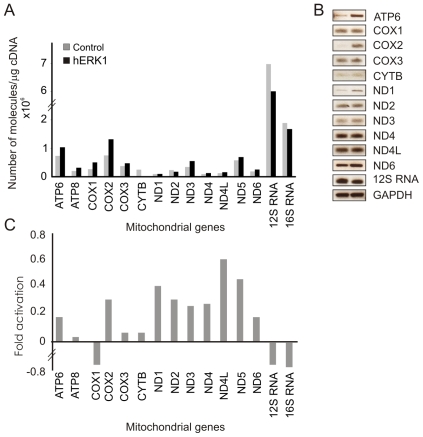
ERK modulatory effect on mitochondrial gene expression.Mitochondria from HeLa cells isolated and incubated with hERK1 for 1 h at 37°C in an in organello RNA synthesis assay (see experimental procedures). mtRNA isolated and every mitochondrial gene expression evaluated by (A) Real time PCR, or (B) Semiquantitative PCR. GAPDH used as housekeeping gene. (C) Mitochondrial gene expression also studied by microarray (see experimental procedures). Mean fold-activation for every gene after ERK treatment of mitochondria (See also Table 2). ND: NADH dehydrogenase; ATP: ATP synthase; COX: cytochrome oxygenase. CYTB: cytochrome b. Number indicates subunit.